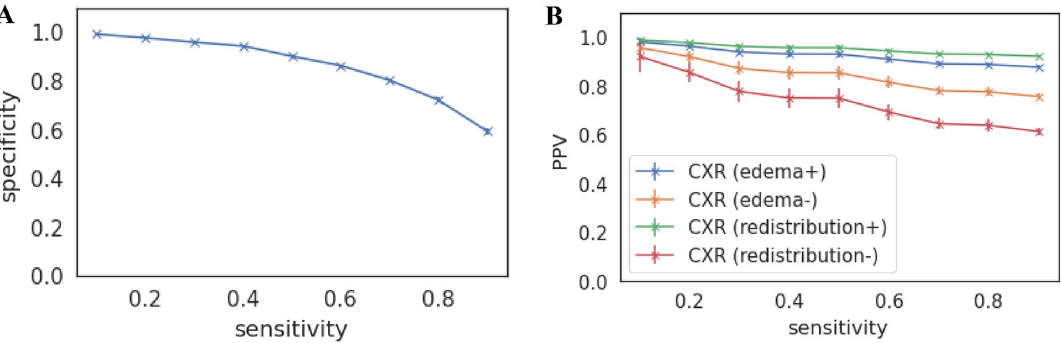
Figure 3. HFNet predictive value. ( A ) Specificity vs Sensitivity on the entire internal holdout set; ( B ) PPVs on the subcohort of the internal holdout set with reduced Ejection Fraction (EF < 40) and as a function of CXR findings on present on presentation. CXR(edema +) = evidence of interstitial edema; CXR(edema −) = interstitial edema absent; CXR(redistribution +) = evidence of pulmonary vascular redistribution; CXR(redistribution −) = no pulmonary vascular redistribution noted. Prevalence of different CXR findings in patients with reduced LV function taken from reference 18 . Plots show mean and standard deviation over 10